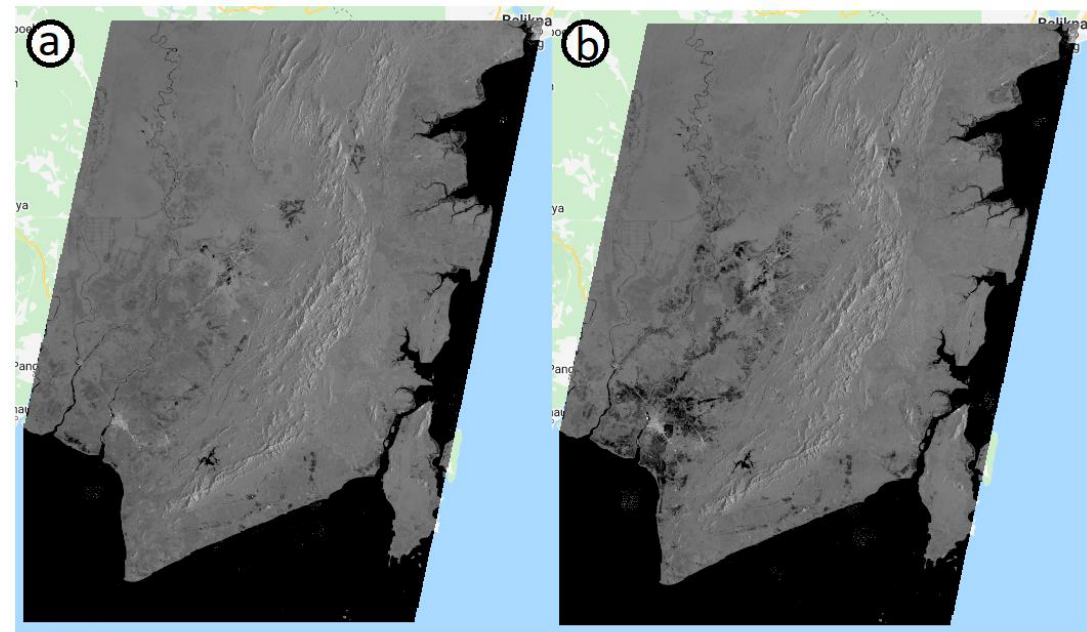
Figure 2 . Backscattering Data (Sigma-nought imagery) from Sentinel-1 GRD, VH Polarization: (a) Sigma-nought image of before flood event (17/08/2020); (b) Sigma-nought image of during flood event